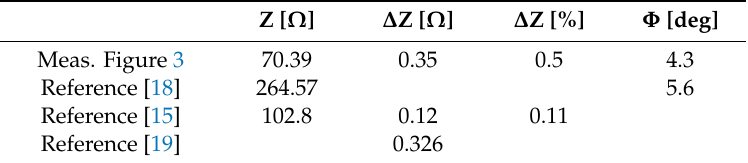
Table 1. Impedance measurement base values, variations due to cardiac activity and phase angle. Z [ Ω ] ∆ Z [ Ω ] ∆ Z [%] Φ [deg] Meas. Figure 3